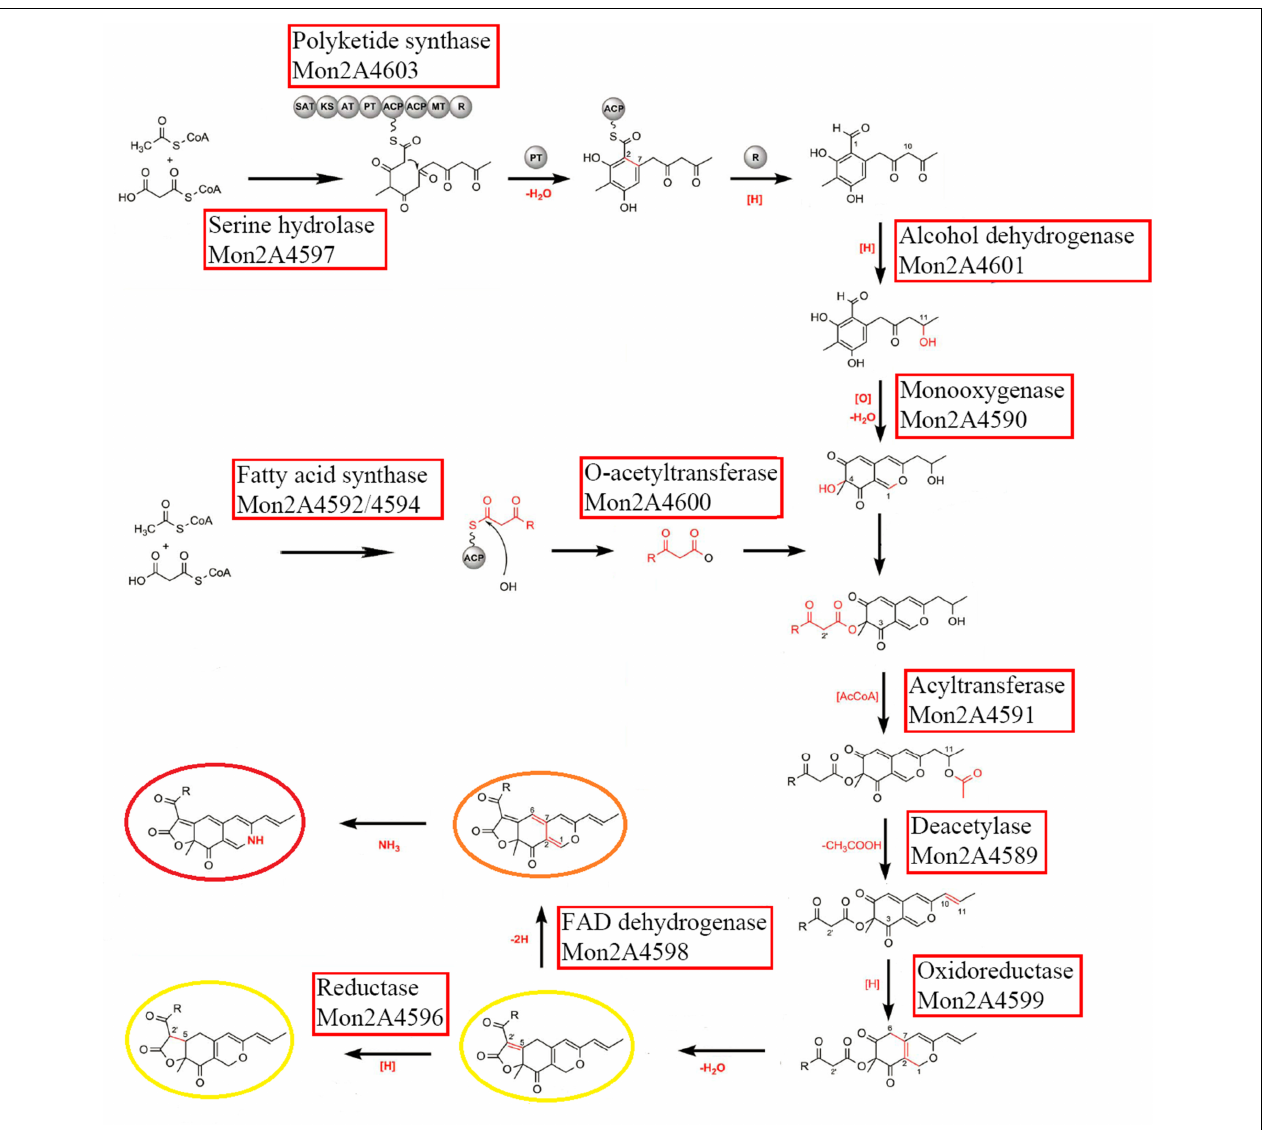
FIGURE 8 | Putative Monascus pigments (MPs) biosynthesis pathway involved with the polyketide synthase (PKS) enzymes in Monascus purpureus RP2. The figure was modified with reference to Scheme 2 by Chen W. et al.